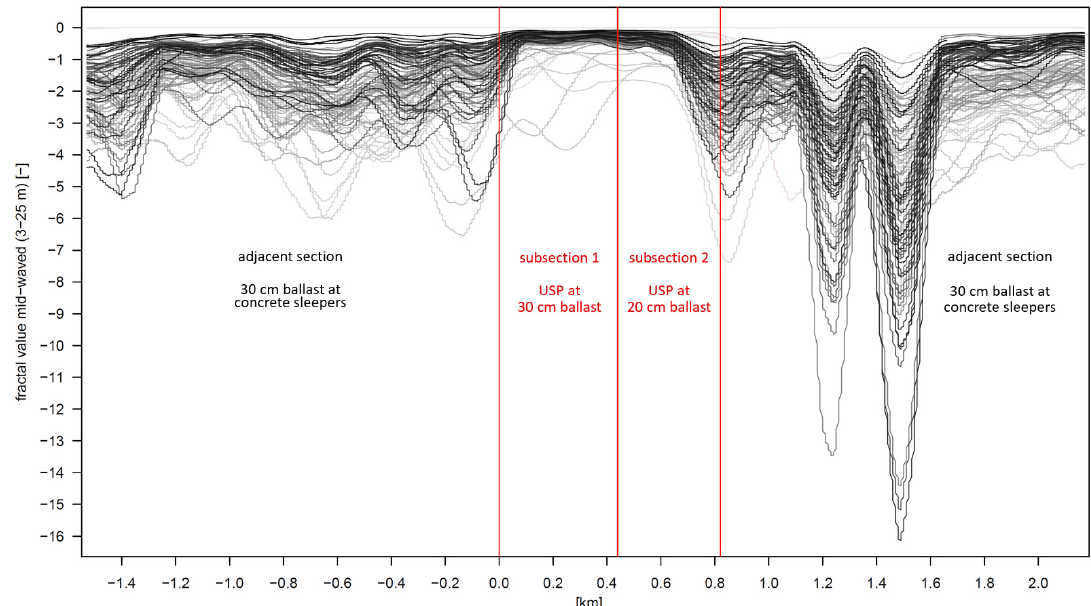
Figure 6. Fractal analysis of the mid-waved dimension, indicating the ballast condition of the test section and the adjacent track segments.